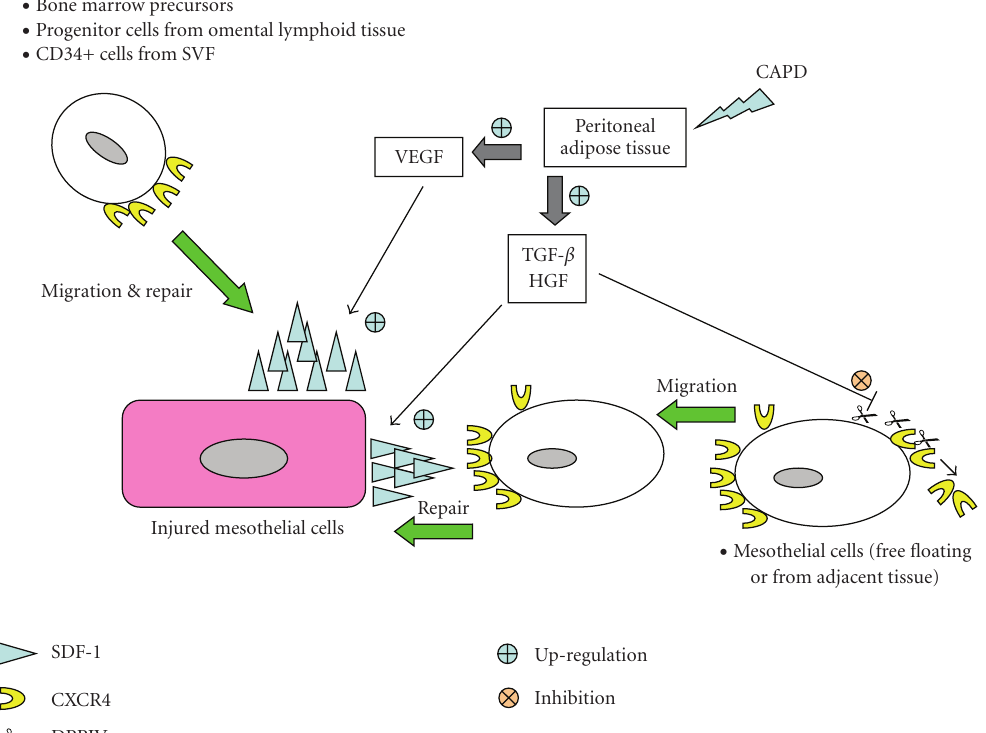
Figure 2: Schematic model illustrates the roles of adipokines or cytokines from adipose tissue on the repair of mesothelium under the context of CAPD. DPPIV indicates aminopeptidase dipeptidyl peptidase IV; CXCR4, G-protein-coupled chemokine receptor; SDF-1, stromal derived factor-1; SVF, stromal vascular fraction; TGF- β , transforming growth factor- β ; TNF- α , tumor necrosis factor- α ; VEGF, vascular endothelial growth